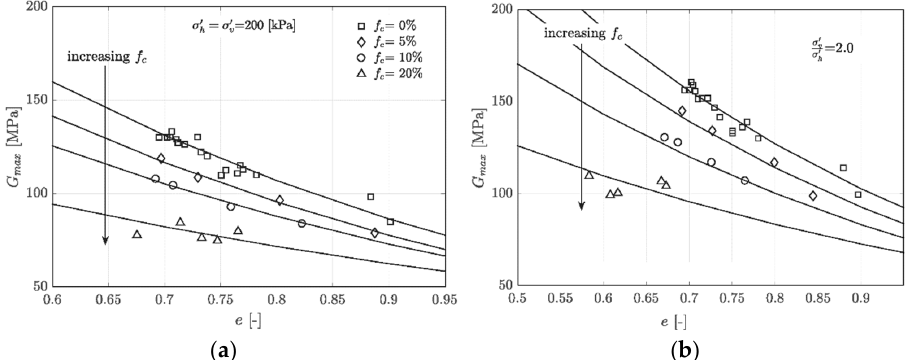
Figure 8. Variation of the G max with different void ratios and fines content under ( a ) isotropic and ( b ) anisotropic stress states.